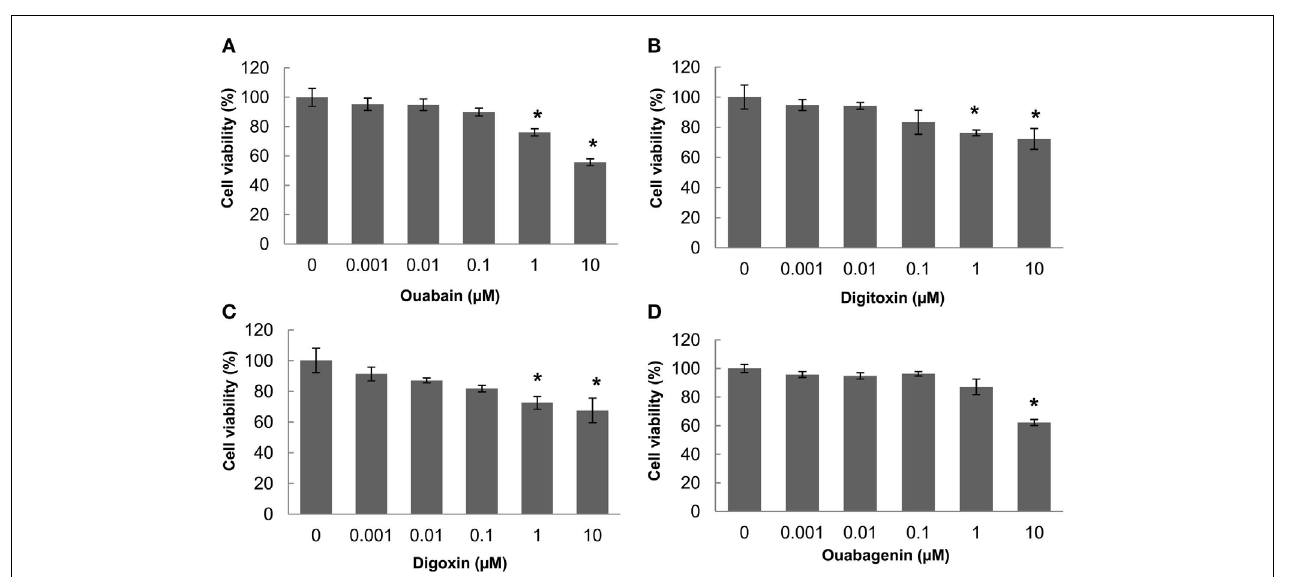
measured using the AlamarBlue assay.The bar graph shows the percentage of the number of viable cells compared with the number of untreated cells, which were assigned a value of 100% (data shown are the mean ± SD of n = 9; * P <